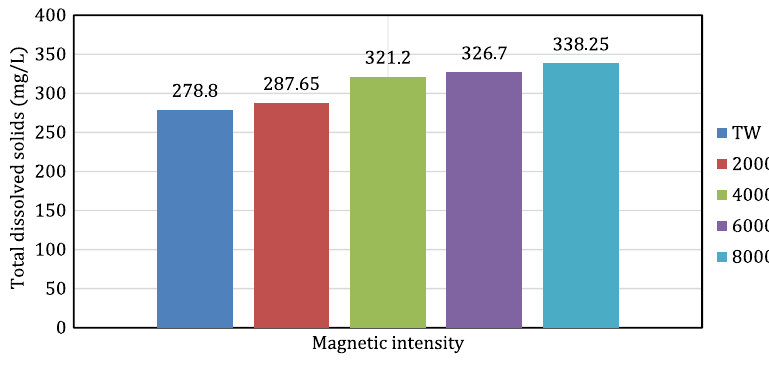
Figure 6: Variation in TDS with the increase in MF intensity.